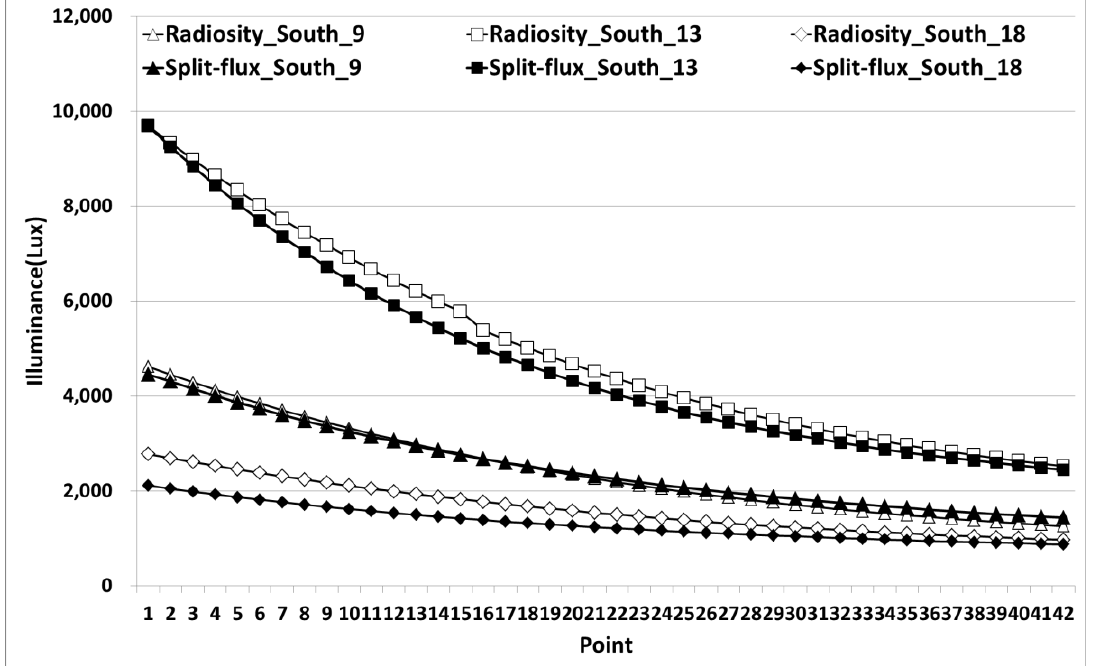
Figure 3. Interior illuminance at 42 reference points at 09:00, 13:00 and 18:00 for South orientation of window.